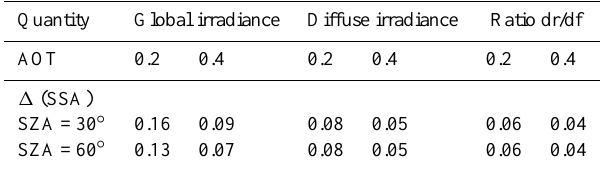
Table 1. Estimated uncertainty on the SSA retrieved from spectral global and diffuse irradiances and from the direct-to-diffuse irra- diance ratio (dr/df) at 380nm for two AOT, at two SZA. Similar results were obtained at 340 and